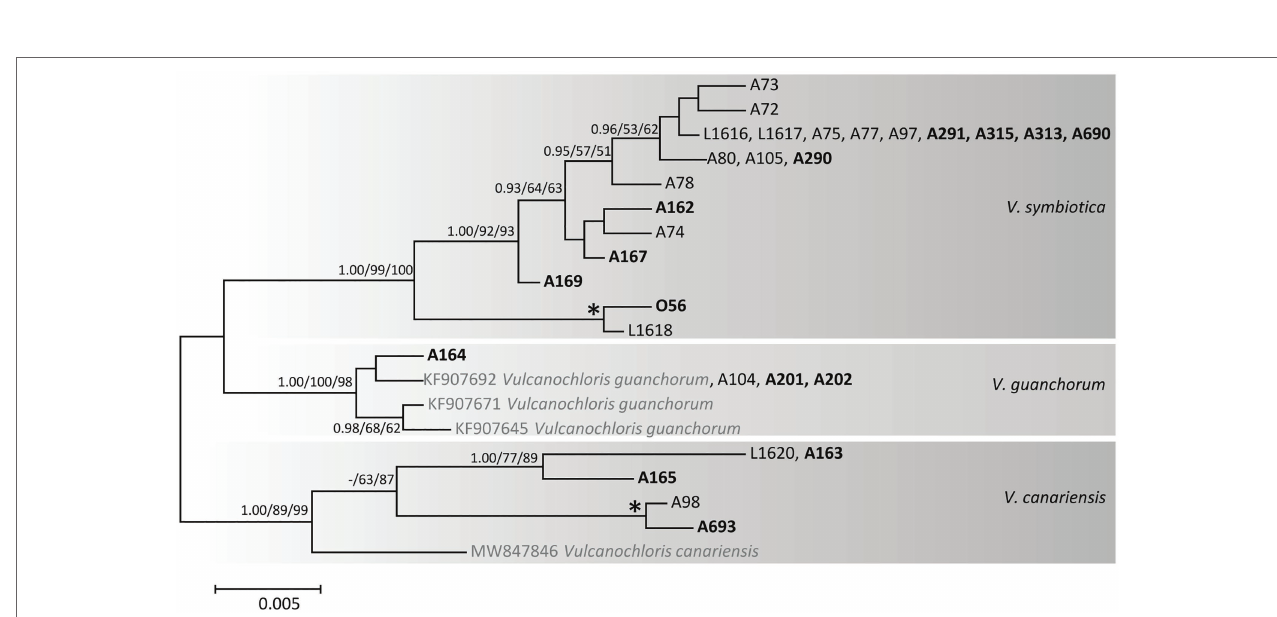
FIGURE 4 | Phylogenetic hypothesis (unrooted tree) of Vulcanochloris resulting from Bayesian analysis of ITS rDNA. Values at the nodes indicate the statistical supports of Bayesian posterior probability (left), maximum-likelihood bootstrap (middle) and maximum parsimony bootstrap (right). Fully supported branches (1.0/100/100) are marked with an asterisk. Scale bar shows the estimated number of substitutions per site. Newly obtained sequences are marked in bold, reference sequences from GenBank are in